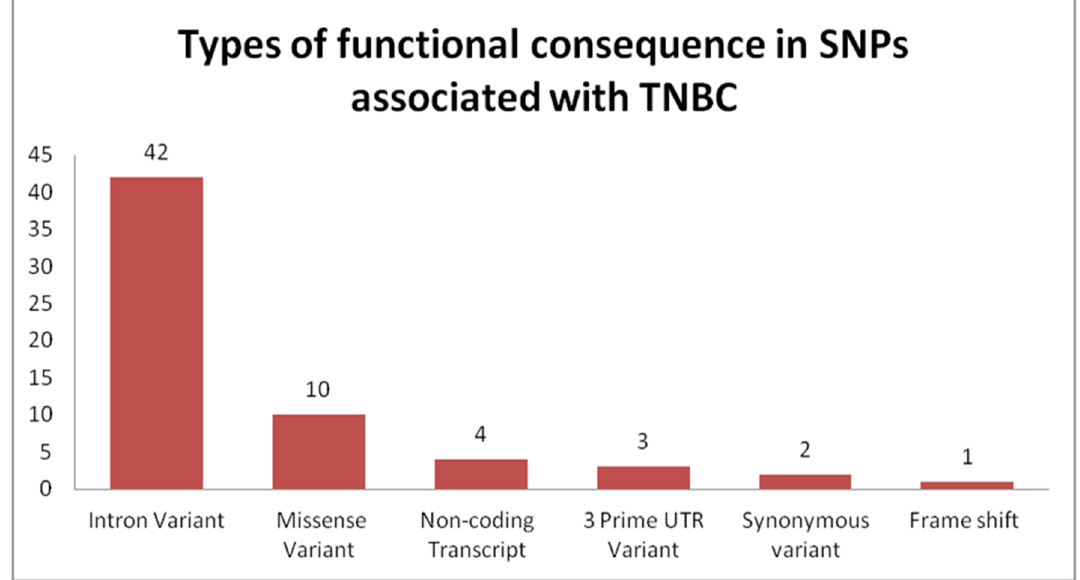
Figure 2. Frequencies of each type of functional consequence caused by single nucleotide polymorphisms (SNPs) associated with TNBC. Abbreviations: SNPs, single nucleotide polymorphisms; TNBC, triple negative breast cancer; UTR, untranslated region.